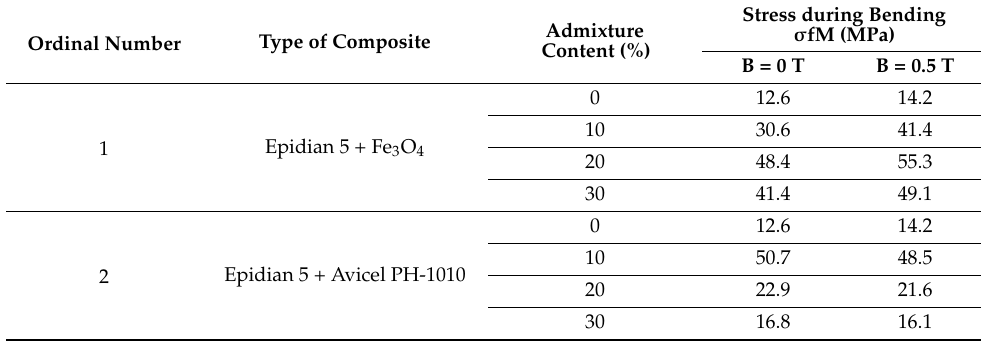
Table 14. Comparison of the mechanical bending strength of composites.